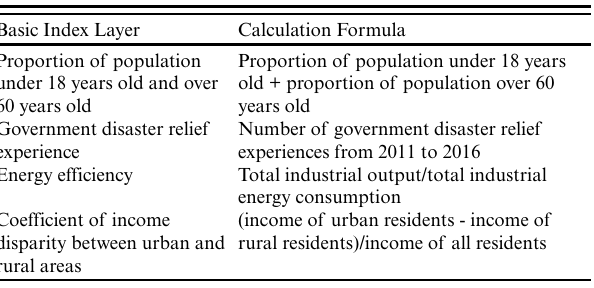
Table 1 . Indicator calculation